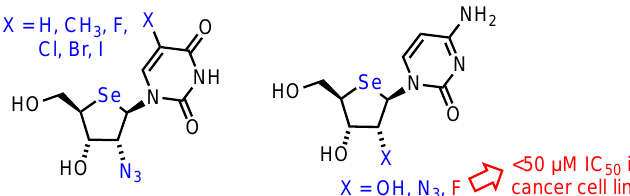
Figure 6. 2’ -Substituted- 4’seleno ribo furanosyl nucleosides reported by Jeong.